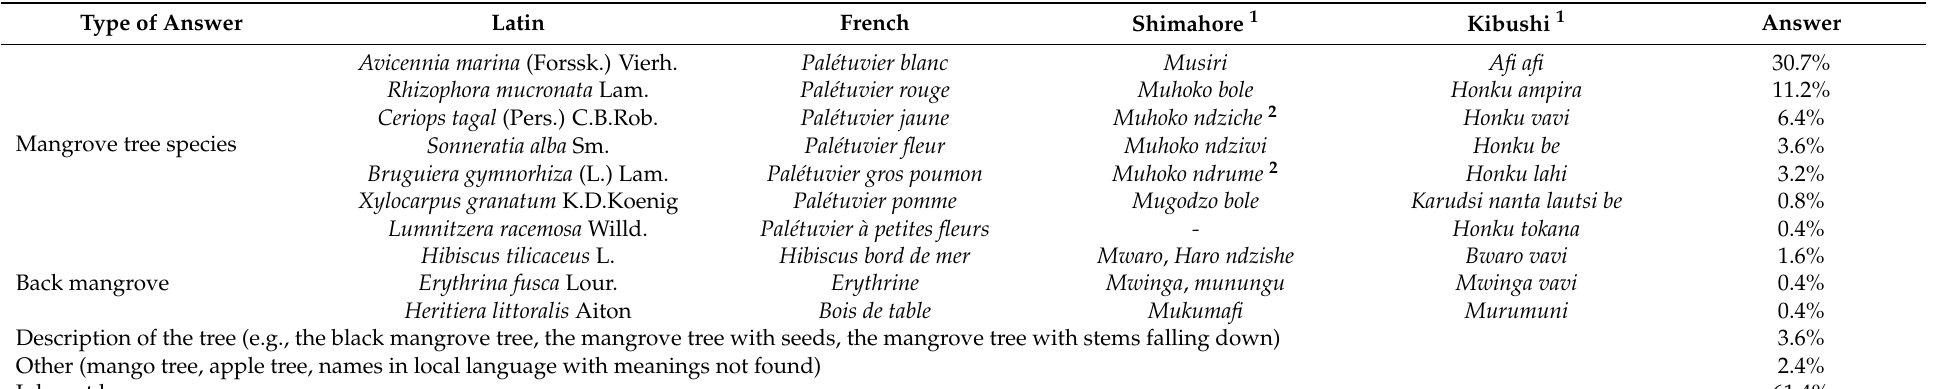
Table 1. Knowledge on the name of mangrove tree species ( n =